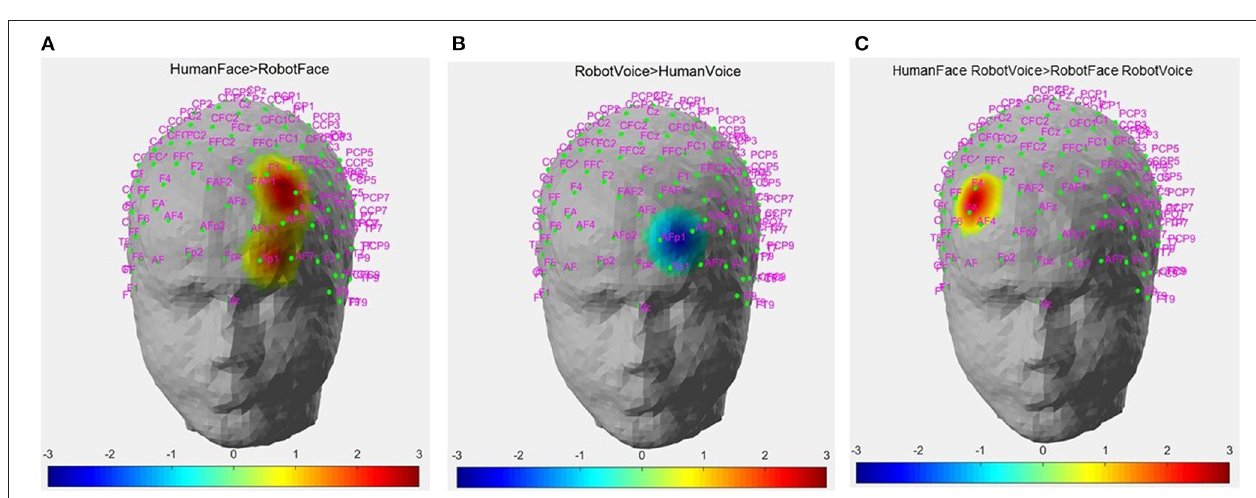
FIGURE 6 | Hemodynamic activation maps obtained during different contrasts between audiovisual stimuli. (A) Human Face > Robot Face contrast, (B) Robot Voice < Human Voice contrast, (C) Face-voice interaction: Human Face-Robot Voice > Robot Face-Robot Voice contrast. T scores of channels showing statistically significant activation ( p < 0.05) are mapped on to the standard head model map. Color bar represents threshold t statistic scores.